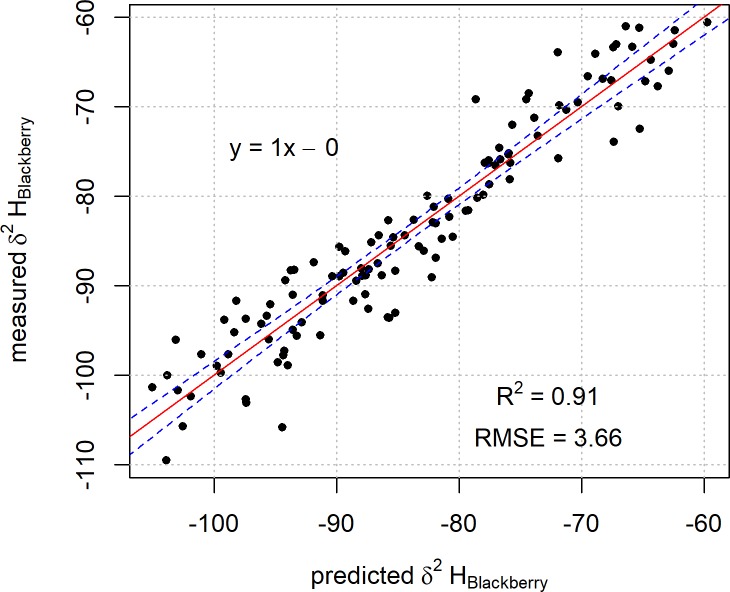
Plot of predicted blackberry leaf δ2H values determined from Model 3 against the measured blackberry leaf δ2H values.The linear regression line of best fit is represented by the red line with 99% confidence intervals for the fit in blue.